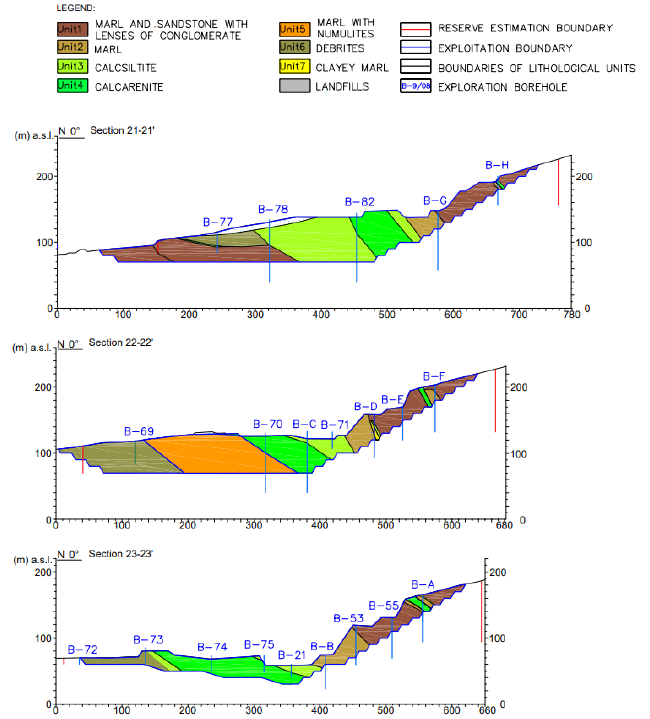
Figure 3. Geological sections 21–21 ′ , 22–22 ′ and 23–23 ′ (according to